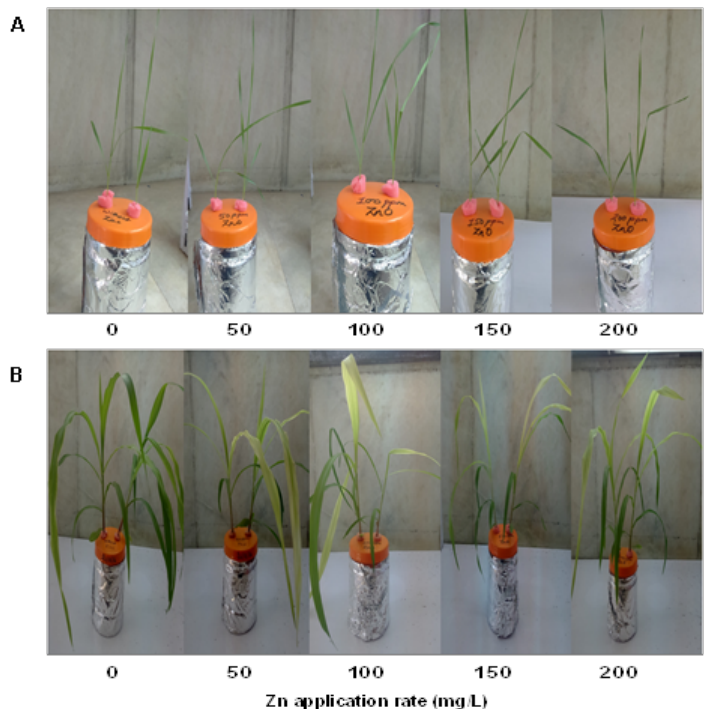
Figure 1. Representative images of plants of wheat ( A ) and maize ( B ) treated with different doses of zinc oxide nanoparticle.